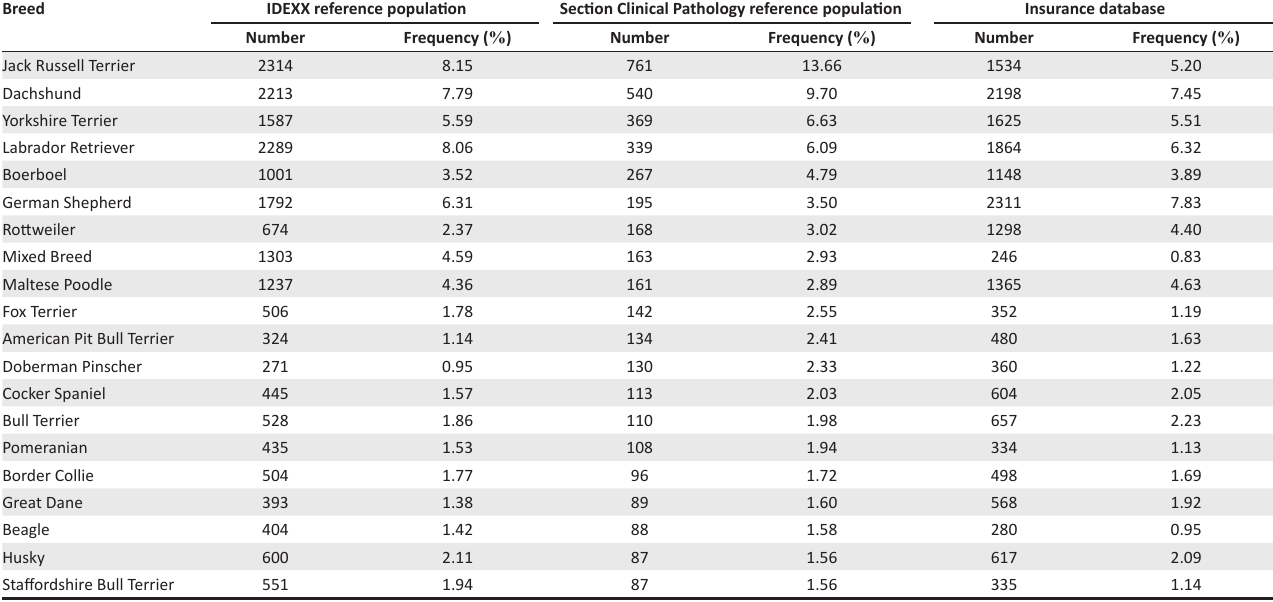
TABLE 1: List of dog breeds, as well as their absolute numbers and frequencies, in each reference population as well as in a pet insurance population. Breed IDEXX reference